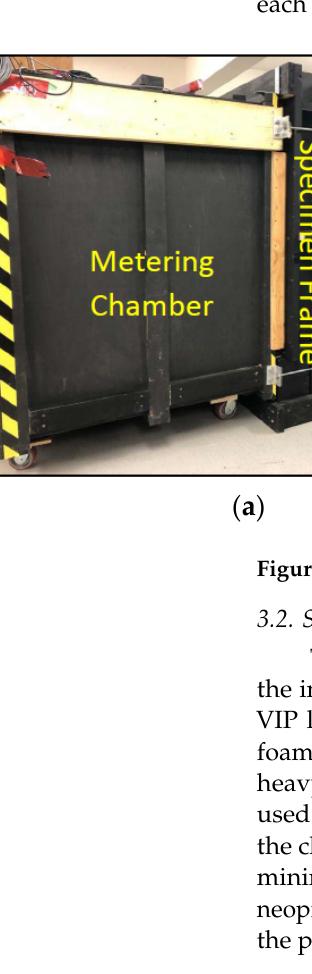
Table 2. Materials’ properties